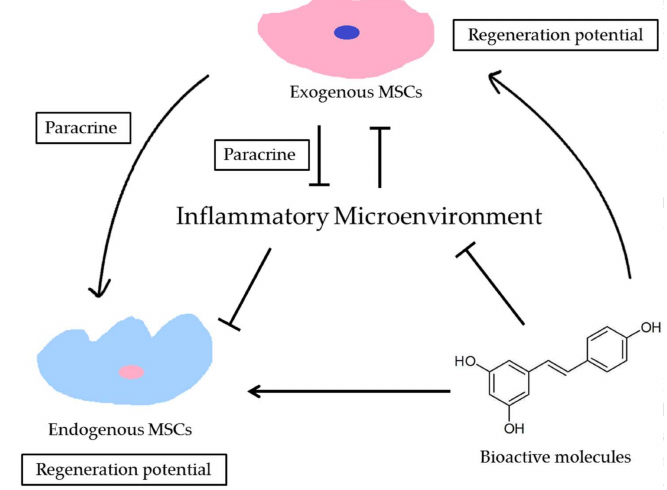
Figure 1. The schematic diagram of the interaction among bioactive molecules, mesenchymal stem cells (MSCs) and inflammatory microenvironment. Since inflammatory microenvironment could suppress the regeneration potential of both endogenous and exogenous MSCs, bioactive molecules could directly enhance regeneration potential of MSCs and recreate a favorable microenvironment for periodontal regeneration (Arrows represent positive effect and T-bars represent negative